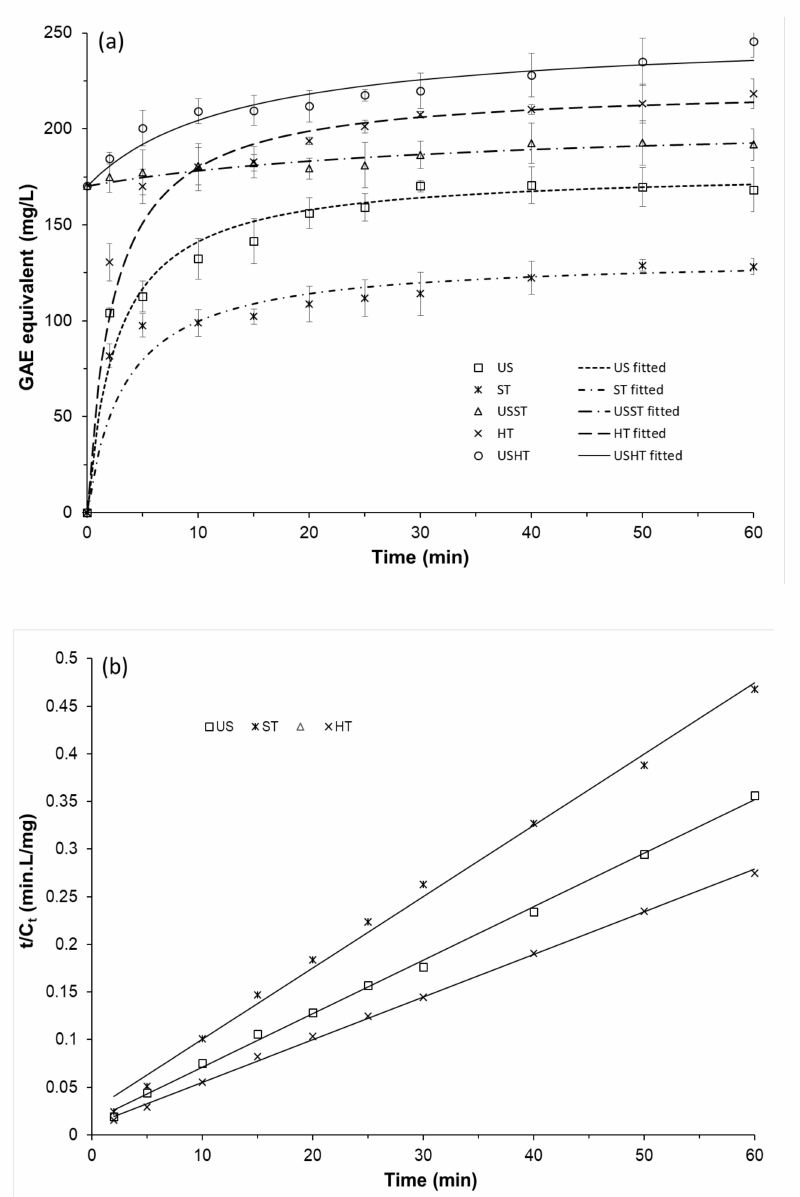
Figure 2. ( a ) Phenolic content of aqueous extracts obtained in the di ff erent processes as a function of time (points) and fitted kinetic model (lines). ( b ) Linearization of experimental points from the ST, US, and HT methods according to the pseudo-second order rate law. (US: ultrasound, ST: stirring, HT: heating, USST: stirring with 30 min of US pre-treatment, USHT: heating with 30 min of US